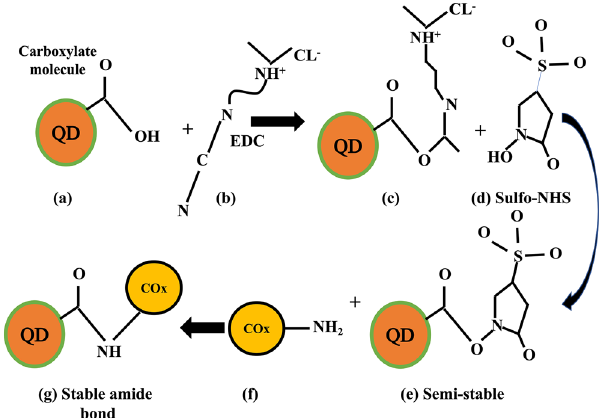
Figure 1. The schematic representation of MAA capping of CdSe/ZnS QDs and conjugation of Cox with CdSe/ ZnS QDs via EDC/NHS in various steps a-g as discussed in the text. The steps involved are (a) formation of carboxylate bond via thioglycolic acid; (b) addition of EDC for activation; (c) unstable reactive ester formed; (d) stabilizer added; (e) semi-stable amine reactive NHS ester; (f) cholestrol oxidase addition; and (g) COx conjugated